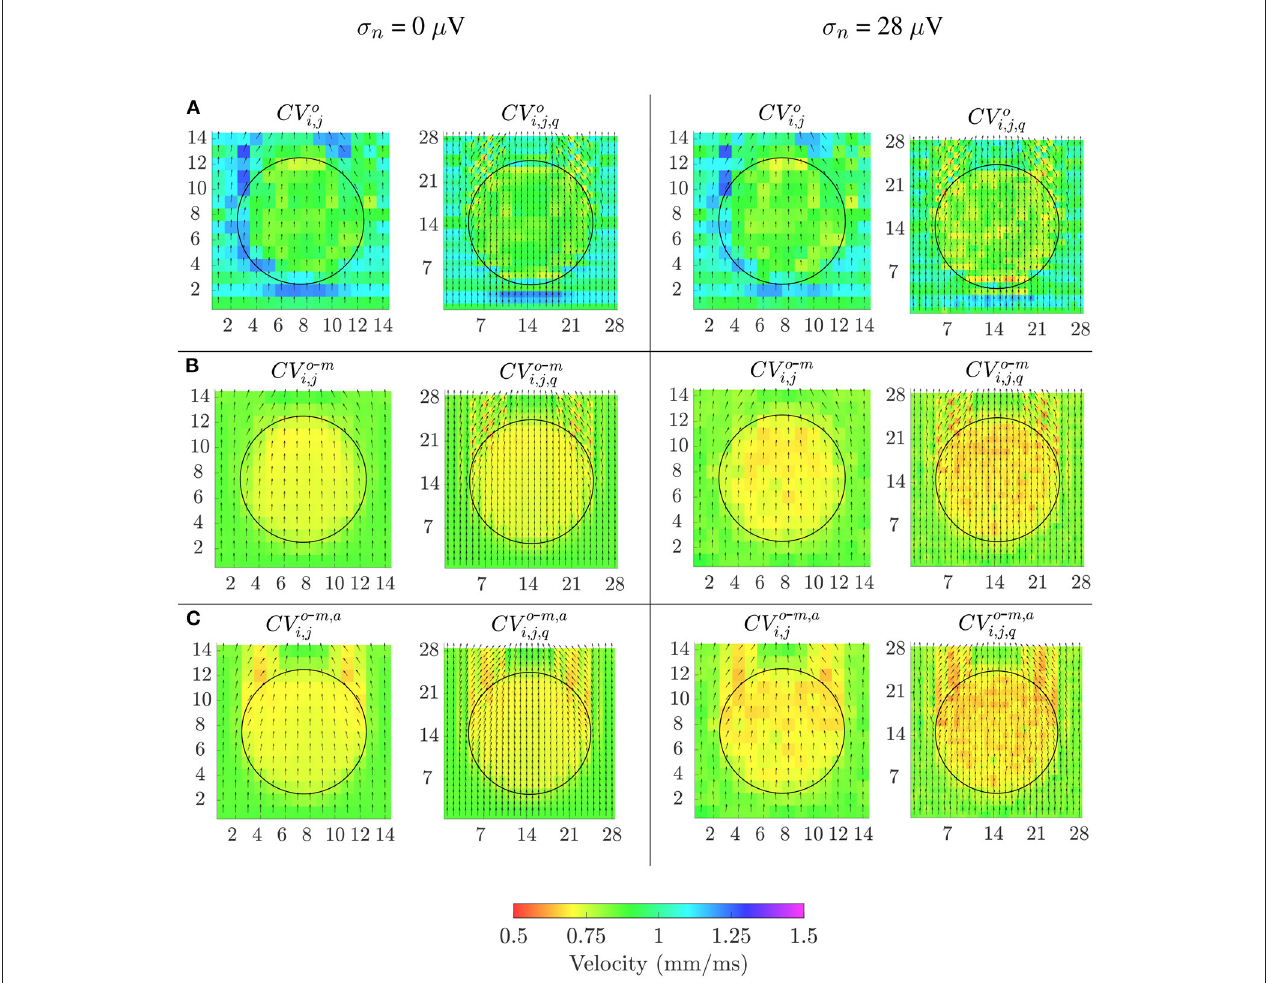
FIGURE 8 | Velocity maps when propagation direction is in the main direction of MEA ( 9 = 0 ◦ ). Estimated conduction velocities are color-coded and arrows show the estimated propagation direction. Left columns: noise-free velocity maps performed with the reference omnipolar method (A) and with the proposed approach (without (B) and with alignement (C) of b-EGMs). Right columns: same types of maps as in left columns, but performed from noise corrupted b-EGMs for a particular realization and noise level with standard deviation σ = 28 µ V